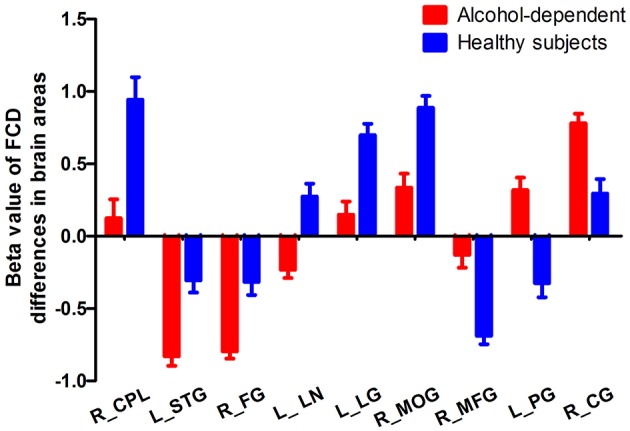
Mean beta value of FCD differences in regional brain areas. FCD, Functional connectivity density; R, right; L, left; CPL, Cerebellum posterior lobe; STG, Superior temporal gyrus; FG, Fusiform gyrus; LN, Lentiform nucleus; LG, Lingual gyrus; MOG, Middle occipital gyrus; MFG, Medial frontal gyrus; PG, Precentral gyrus; CG, Cingulate gyrus.